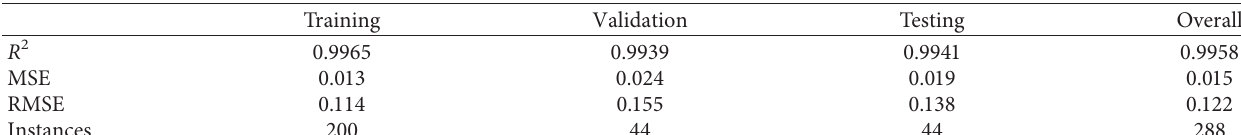
Figure 5: Performance assessment for ANN model. (a) Training state. (b) Best validated performance. Table 6: Performance results of ANN